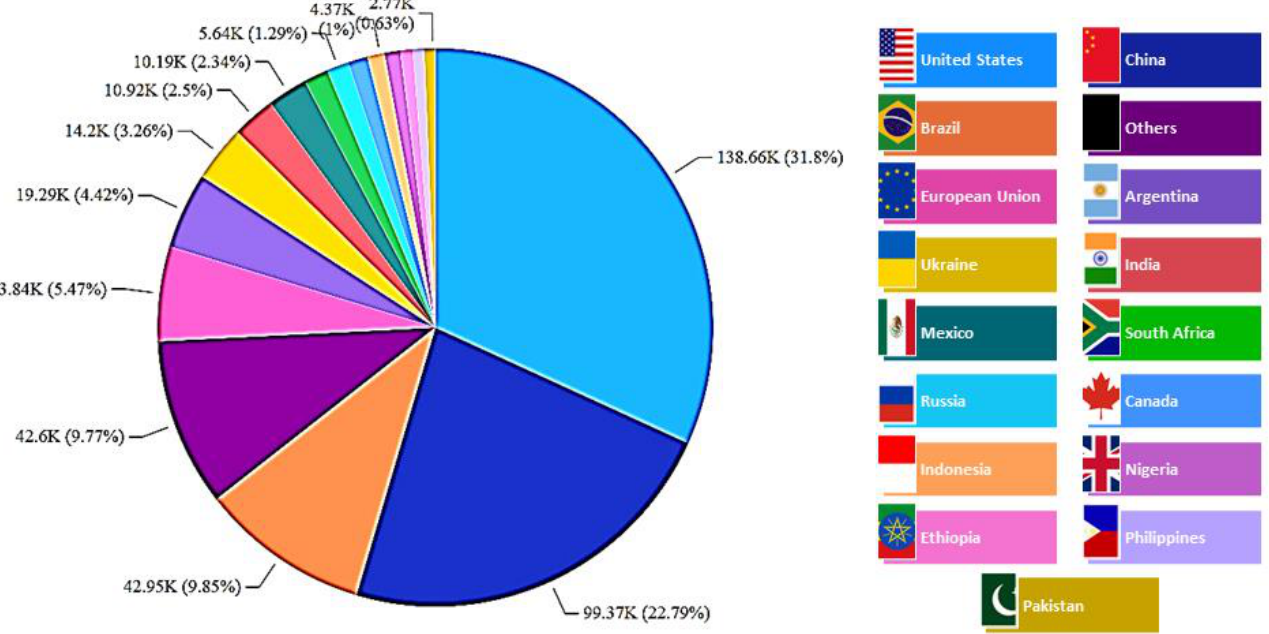
Figure 4. World distribution of cellulosic - waste production from maize (thousand metric tons).